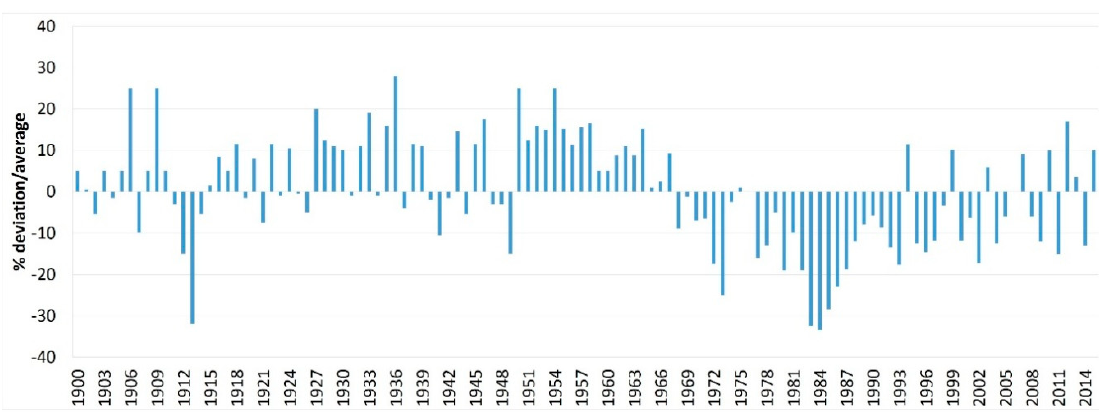
Figure 10. Evolution of annual rainfall index from 1900 to 2015 through the entire Niger River Basin delimited at Niamey station (approx. 700,000 km 2 , from 12° W to 3° E and from 8° to 18° N—see Figure 1a).